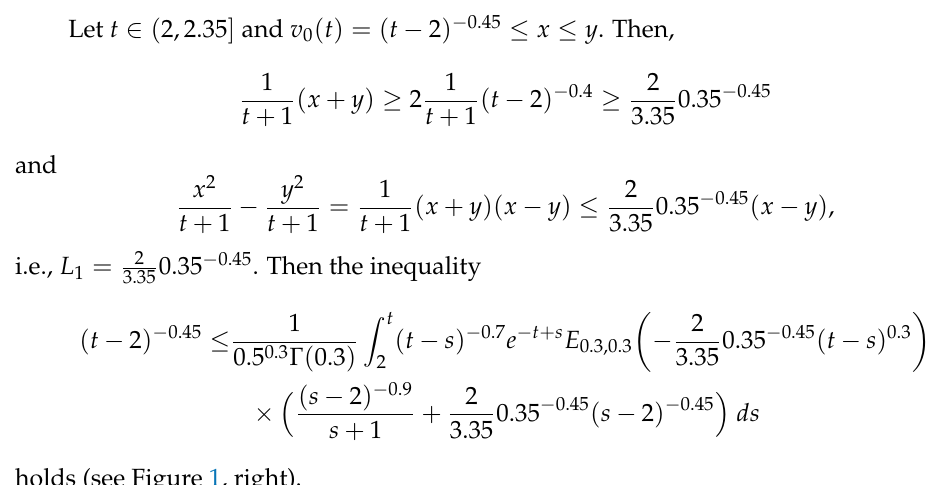
( 2,2.35 ] (right). ( 2,2.35 ] ( right ∈ ∈